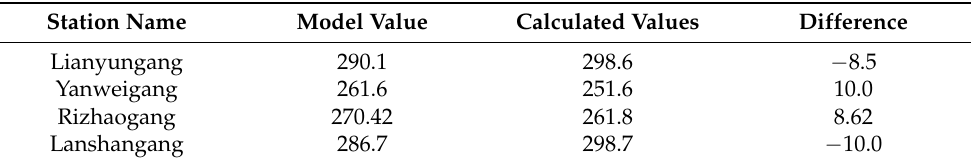
Table 3. Comparison between model values of tide gauge stations and calculated values of tide tables (unit: